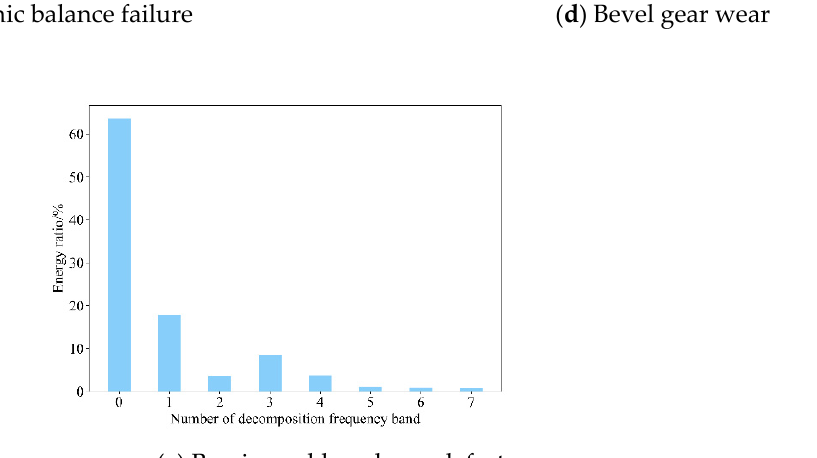
Figure 4. Energy spectrum of vibration signal in x -axis direction. ( a ) Energy spectrum in normal